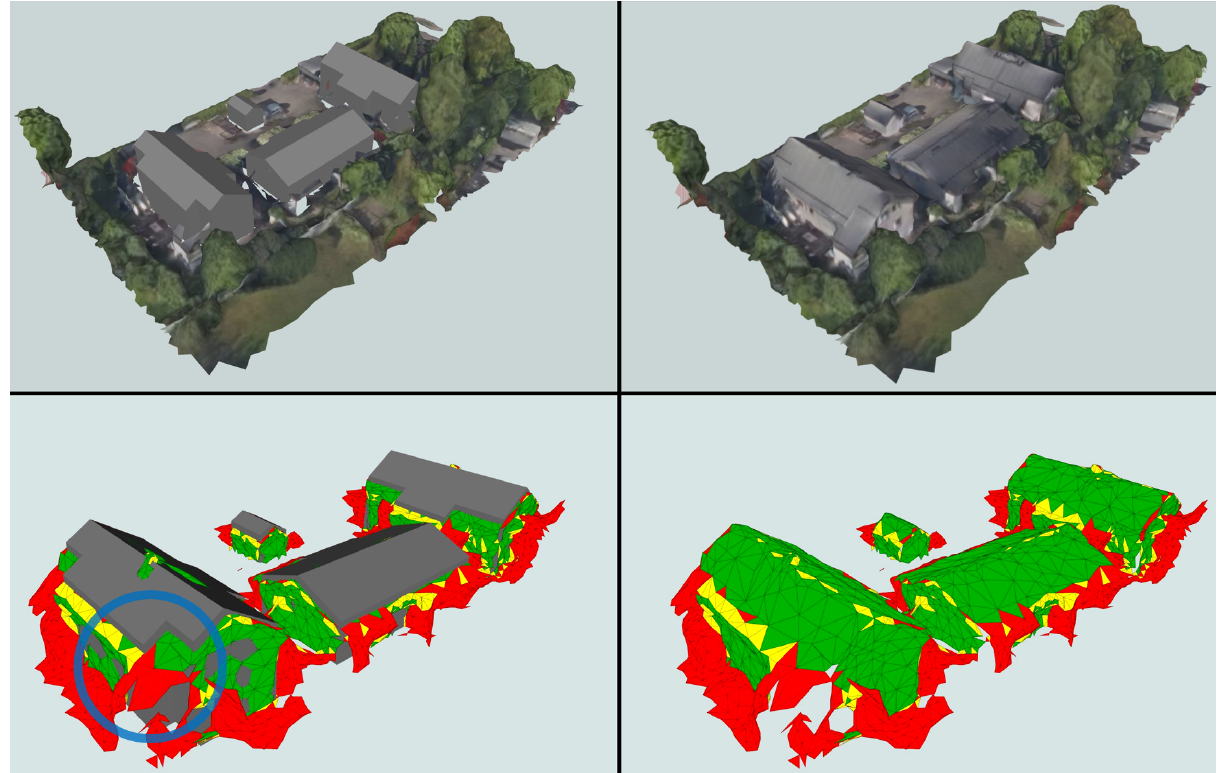
Figure 3. Test area from the Helsinki dataset. The top left image shows the CityGML building model embedded in the mesh model, at the top right the textured 3D mesh model is displayed. The bottom images show the results of the point-to-plane distance measure at a distance threshold d = 1 m with (bottom left) and without the LoD2 building model (bottom right). The triangle colors indicate the angle difference between the normal vectors of the triangles and semantic surface in one ROI ( green < 30 ◦ , yellow 30 − 60 ◦ , red > 60 ◦ ).